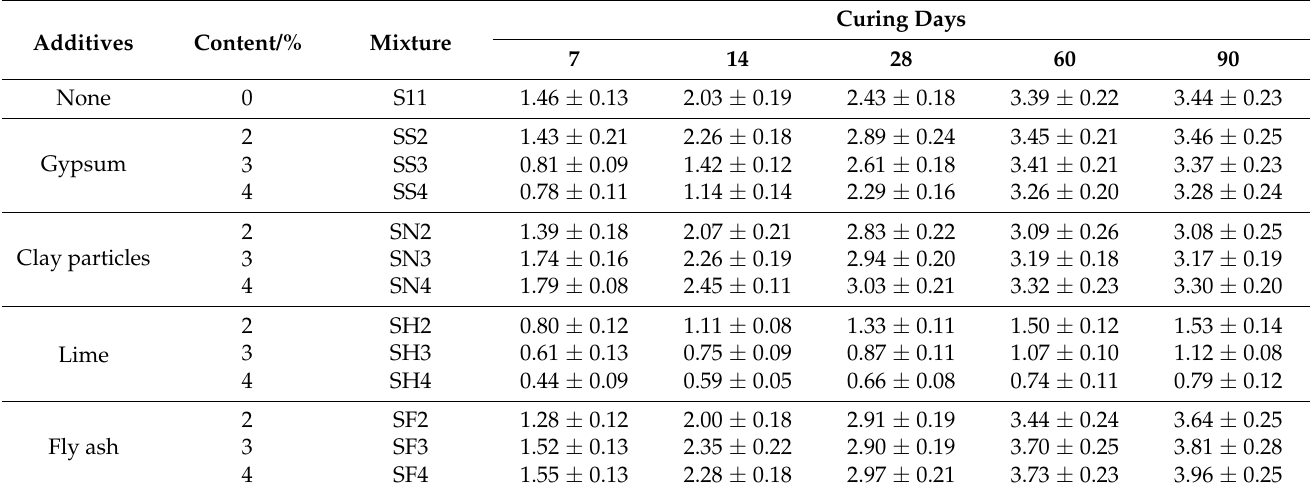
Figure 5. Curve of unconfined compressive strength with optimal content of the additives. Table 4. Test results for unconfined compression strength